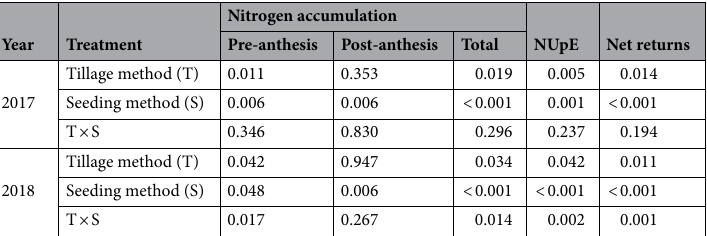
Table 5. Analysis of variance (ANOVA) p -values for the effects of tillage method, seeding method, and their interaction (T × S), on nitrogen accumulation, nitrogen uptake efficiency (NUpE), and the net returns in 2017 and 2018.